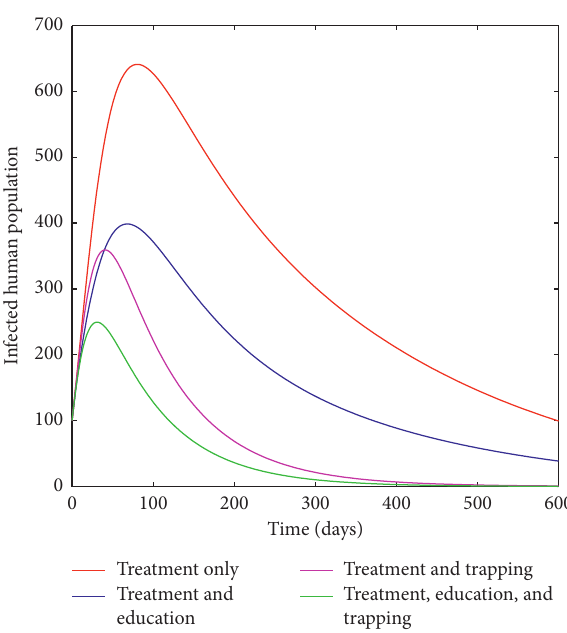
Figure 3: Impact of various interventions on infected human population when θ � 0 .